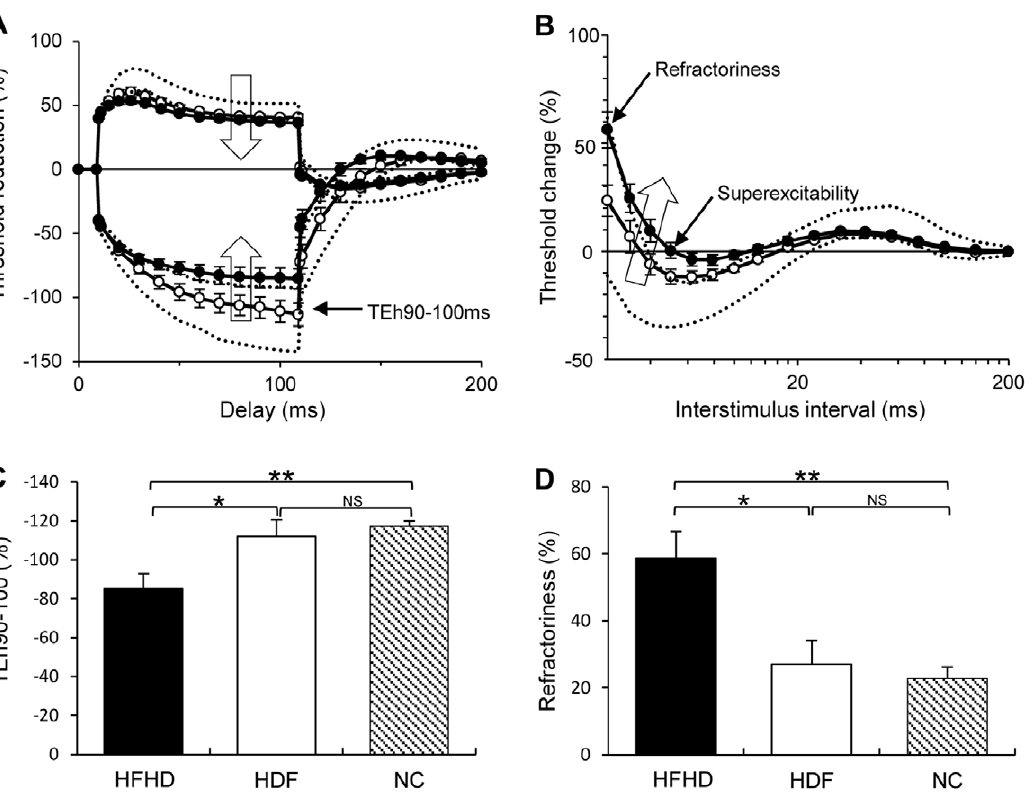
Figure 1. Pre-RRT nerve excitability recordings. Patients receiving hemodiafiltration (HDF) (empty circles) and standard high-flux HD (black filled circles) compared to 95% limits for healthy controls (dashed lines). (A) Depolarising and hyperpolarising threshold electrotonus curves. (B) Recovery cycle curve of excitability, large empty arrows indicate the direction of change with axonal depolarization. In both figures (A) and (B) the HDF group demonstrate results significantly closer to normal values than the HFHD group, specifically at hyperpolarising threshold electrotonus 90– 100 ms (TEh90–100 ms), refractoriness and superexcitability. Figures (C) and (D) demonstrate the group differences in TEh90–100 ms and refractoriness in histogram format. * p , 0.05, ** p , 0.001.